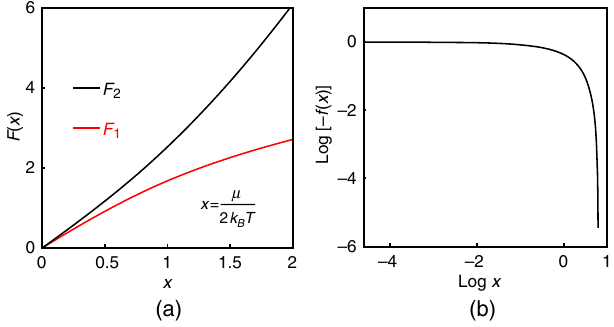
FIG. 3. (a) Scaling of two functions appearing in the expression for the Drude conductivity of the anisotropic semimetal in the x (given by F 1 ) and y (given by F 2 ) directions [see Eq. (2)] versus T Þ . Here μ is the chemi- the dimensionless argument X ¼ μ / ð 2 k B cal potential and T is the temperature. (b) Scaling of the function f ð x Þ versus the dimensionless argument x (the ratio of thermal de Broglie wavelength to magnetic length) that controls the dia- magnetic susceptibility of an anisotropic semimetal at finite temperature [see Eq.